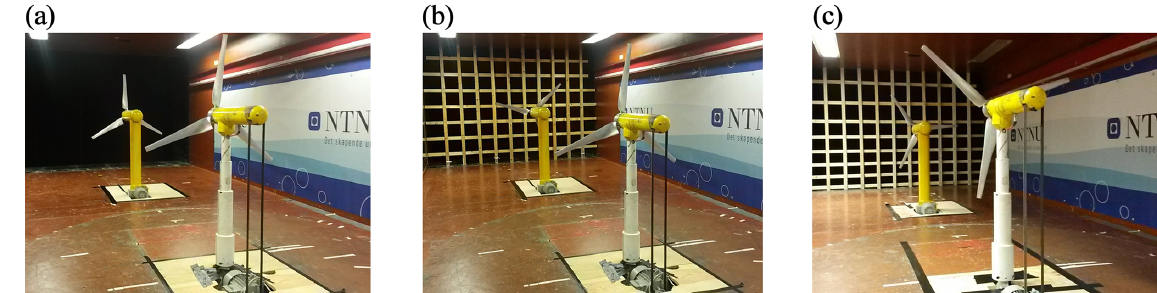
Figure 3. Test case A: low-turbulence uniform inflow (a) ; test case B: high-turbulence uniform inflow (b) ; test case C: high-turbulence shear inflow (c)